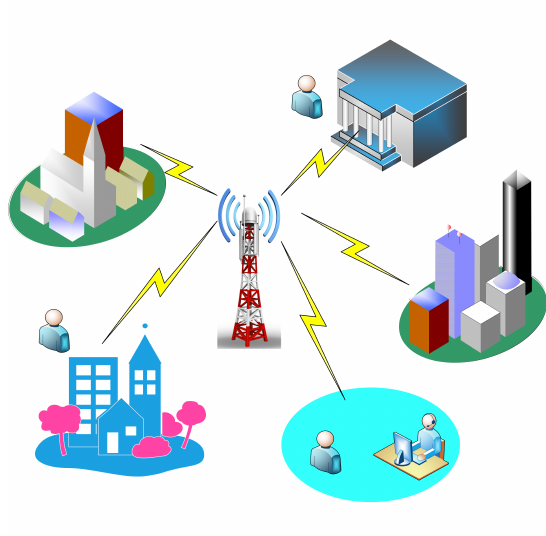
Figure 1. Downlink non-orthogonal multiple access (NOMA)